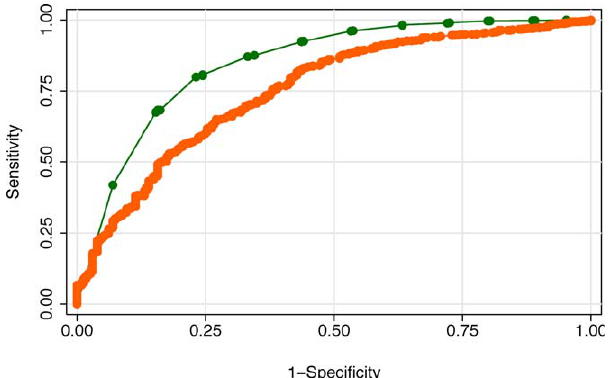
Figure 7. ROC Curve for Adherence and CD4 Count Change when Used to Identify Patients with Virologic Failure at 12 Months after cART Initiation Green and orange dots are observed adherence and CD4 þ T cell count change values, respectively. Thus, the graphs represent the sensitivity and specificity that would result if each observed adherence or CD4 þ T cell count change value were used as a diagnostic test for current virologic failure. The AUC was 0.85 (95% CI 0.82–0.88) for adherence and 0.75 (95% CI 0.72–0.79) for CD4 count change ( p , 0.001, Chi-square test).